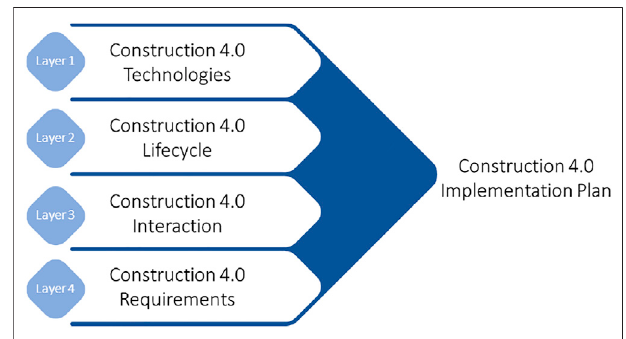
FIGURE 1 | Construction 4.0 implementation